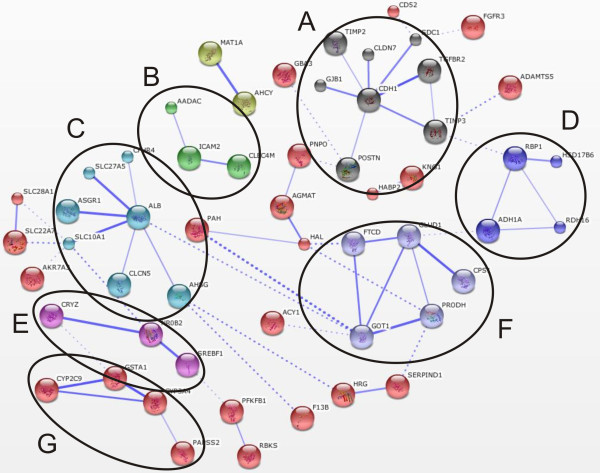
The gene functional clusters identified for the significant, downregulated liver tissue transcriptome. The downregulated liver tissue network (n = 5) contained 7 functional clusters: (A) cell-cell adhesion; (B) leukocytes functioning; (C) amino acids metabolism; (D) redox reactions; (E) sterol metabolism; (F) amino acids and nucleotide metabolism; (G) cytochrome P450.